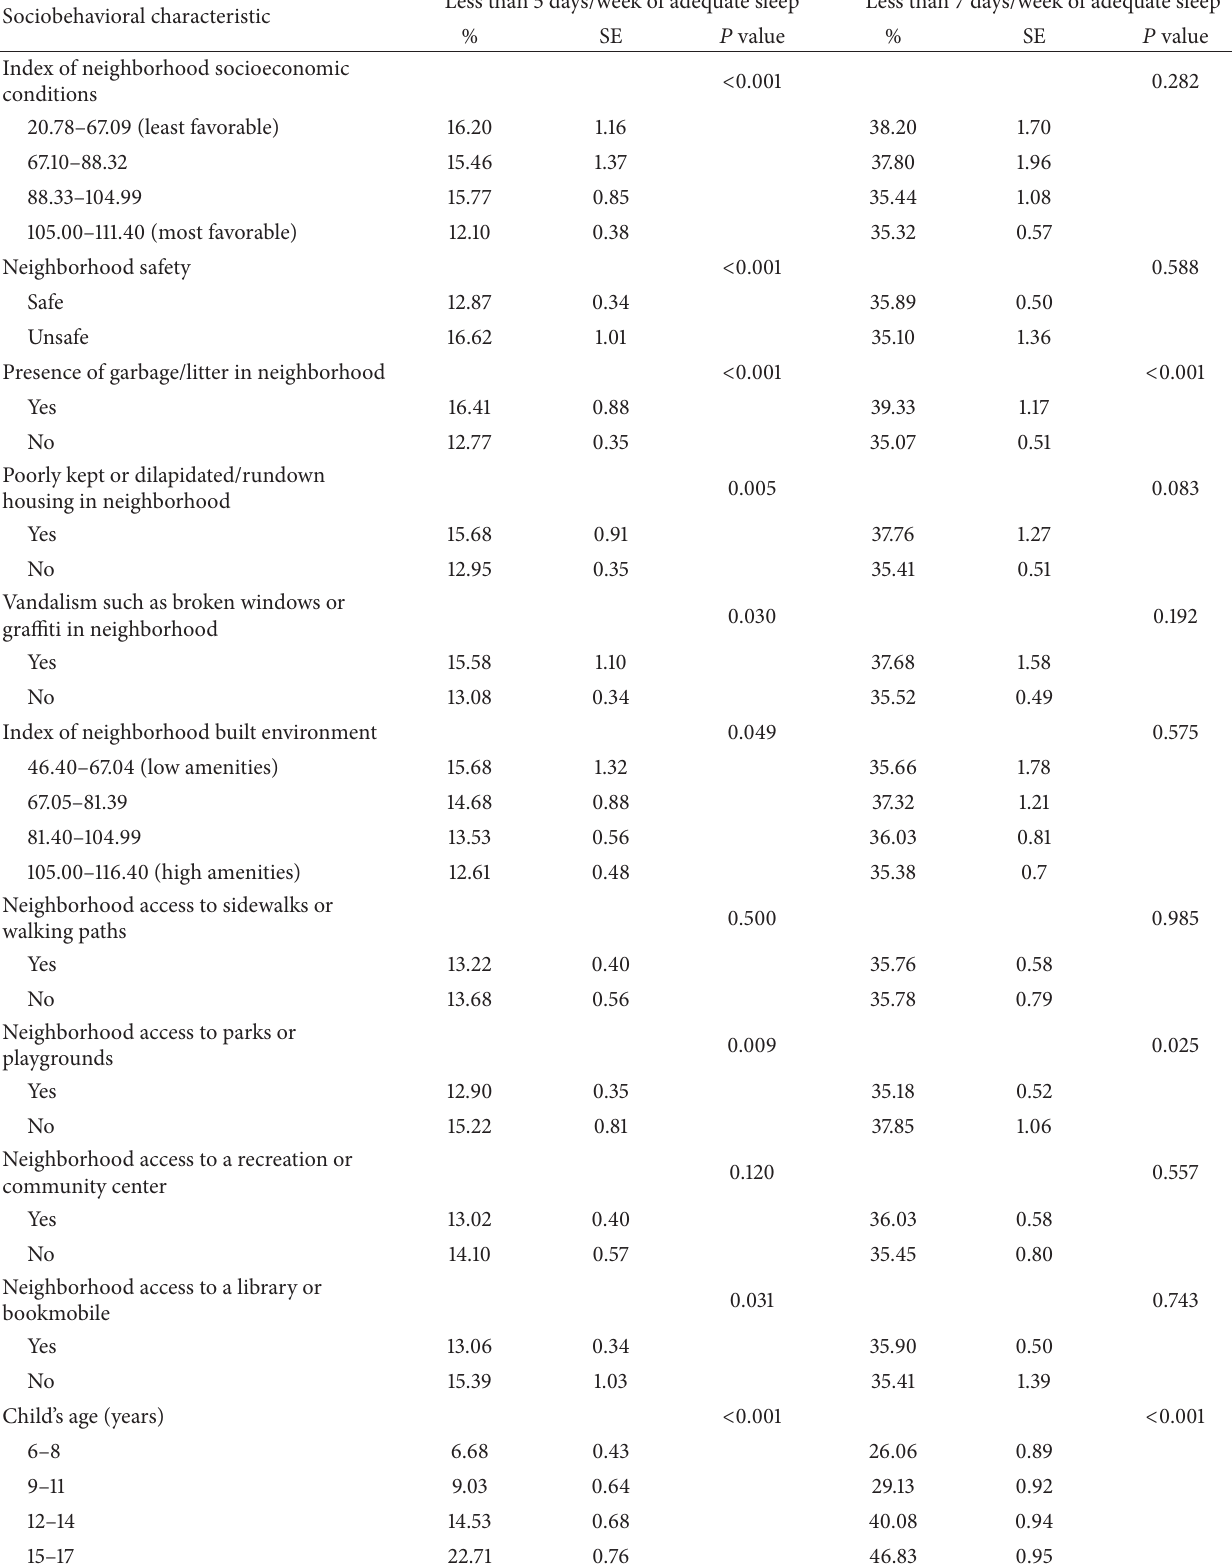
Table 3: Weighted prevalence of sleep problems among US children aged 6–17 by neighborhood, sociodemographic, and behavioral characteristics: the 2007 National Survey of Children’s Health ( 𝑁 =